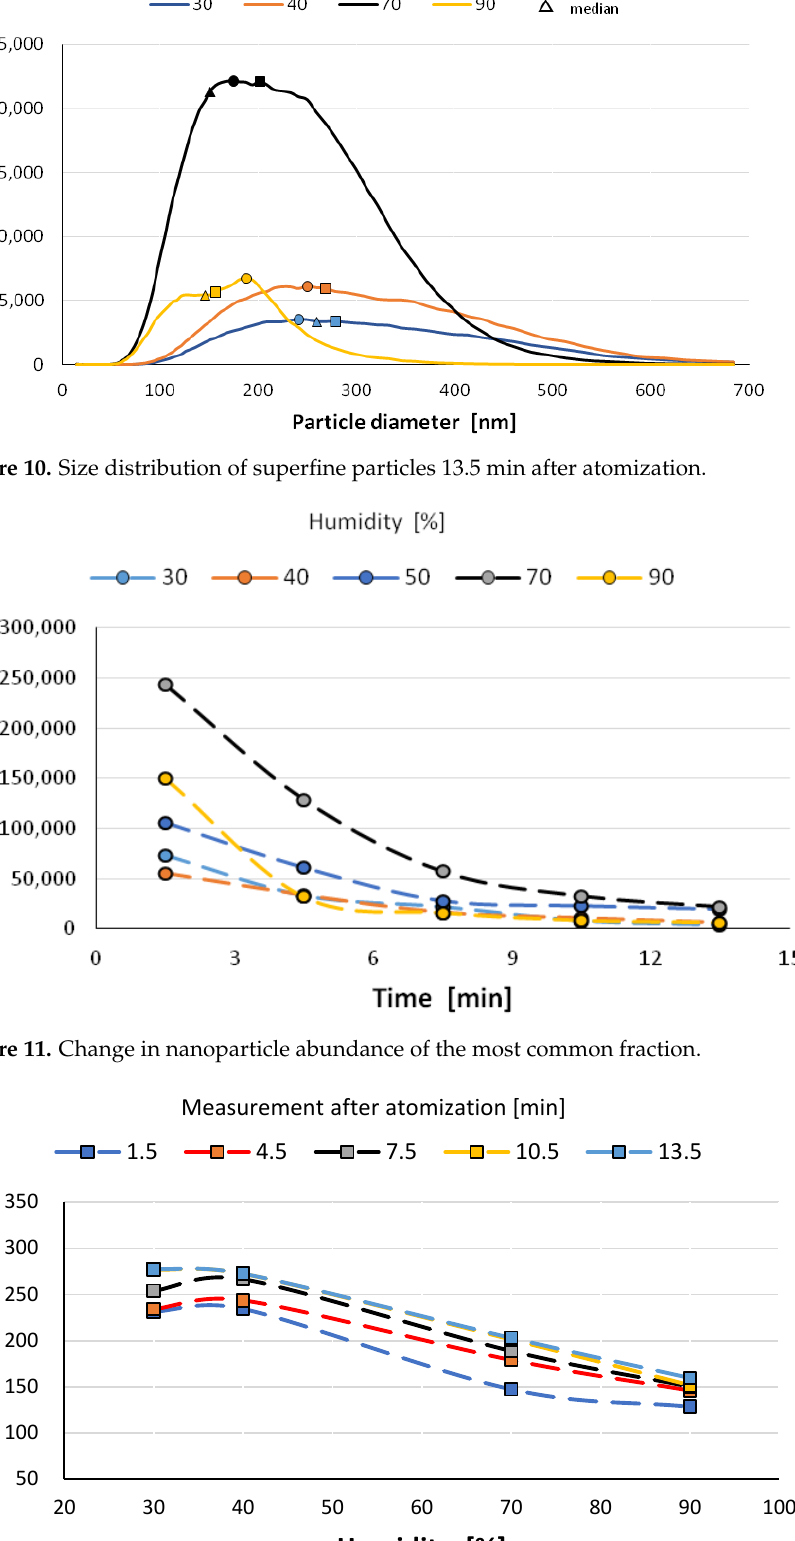
Figure 12. Change in the average size of nano-grain population as a function of humidity environ- ment.